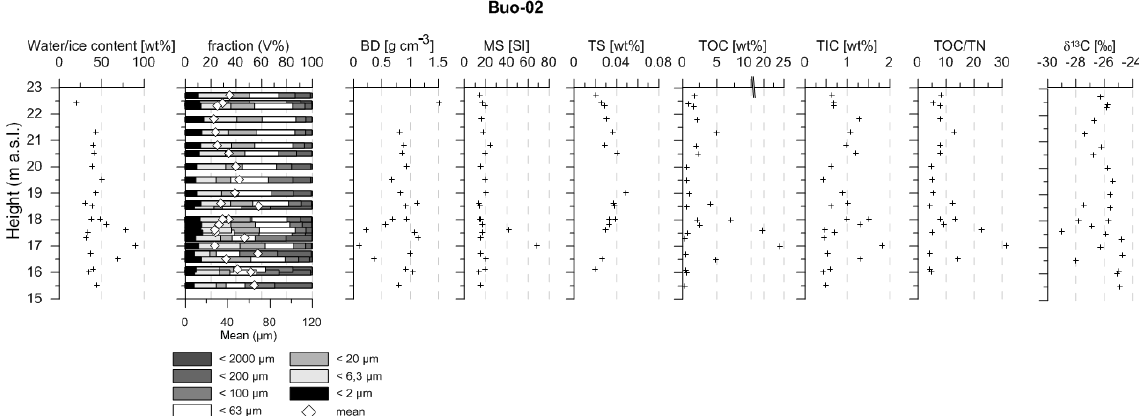
Figure 4. Soil and organic matter properties of the Buo-02 profile (note that due to overlapping sub-profiles, different values may be displayed at similar